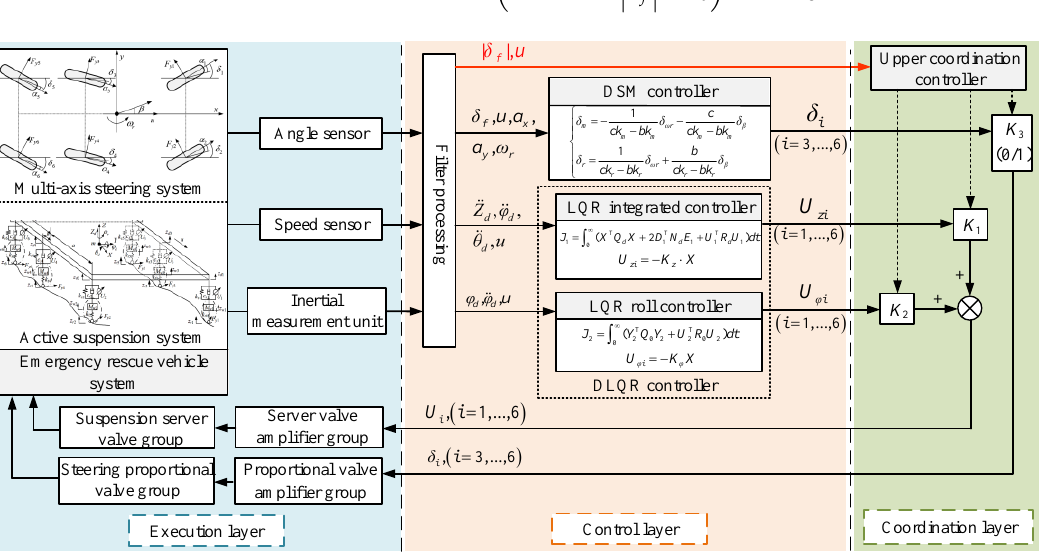
Figure 5. Membership function of K 1 and K 2.